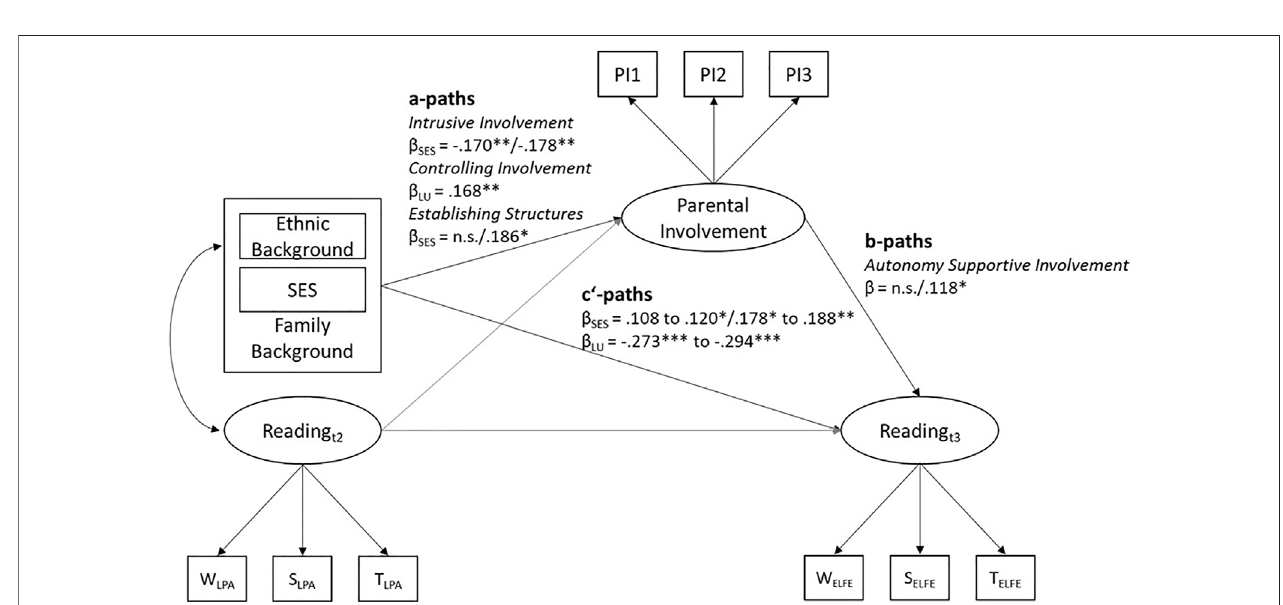
FIGURE 4 | SEM-Mediation model for research question 2. Note: Only signi fi cant a-paths, b-paths, and c ’ -paths are shown. All other coef fi cients are reported in the supplement. * p < 0.05, ** p < 0.01, *** p < 0.001.